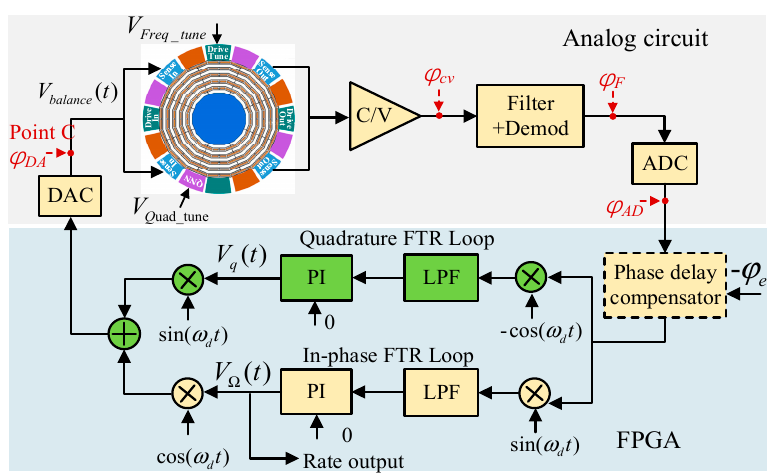
Figure 2. The control scheme of Mode I closed-loop gyroscope system.